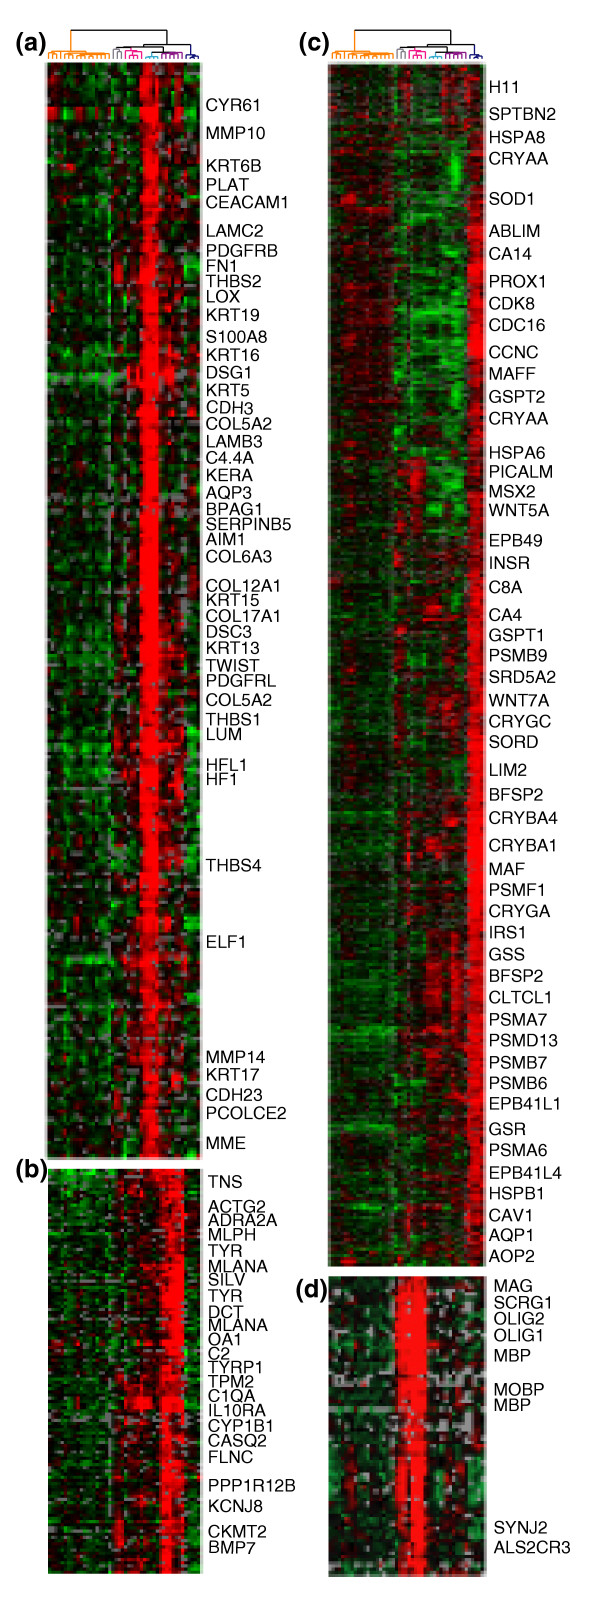
Expanded view of compartment-specific gene expression signatures in the human eye. Data were extracted from Figure 1 and are displayed similarly. Individual clusters depict genes associated with (a) cornea, (b) ciliary body and iris, (c) lens and (d) optic nerve. Many of the array elements encode uncharacterized genes and only a subset of named genes is shown.